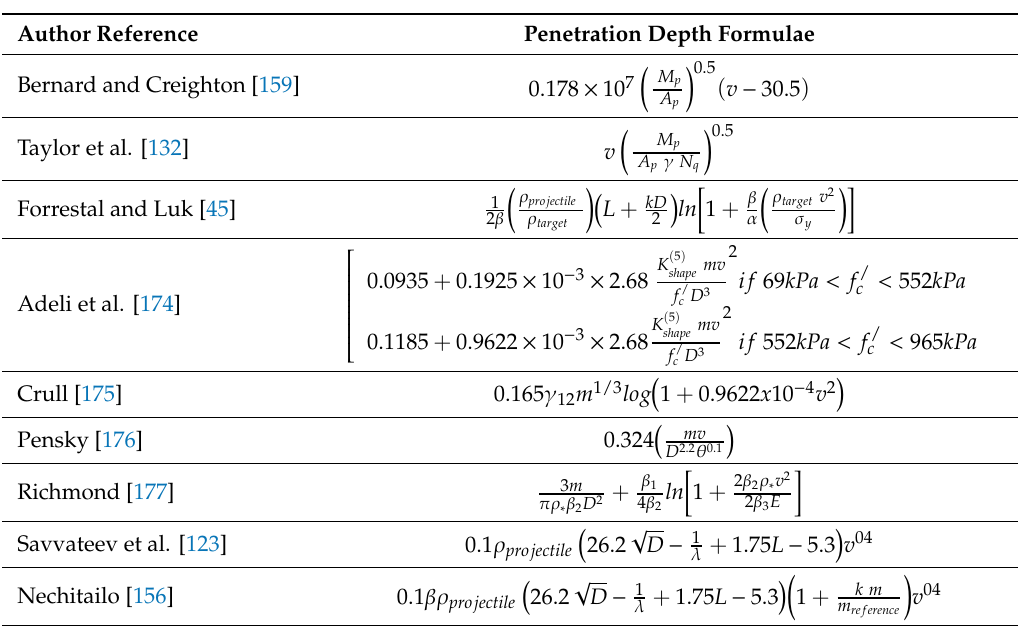
Table A4. Penetration depth Formulae by di ff erent Authors